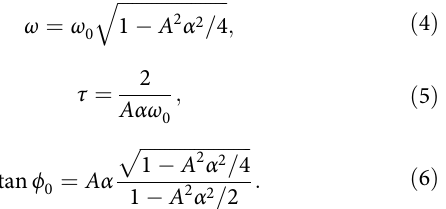
Fig. 2 Z -mode precession in YMnO 3 . a Time-resolved Faraday rotation following the impulsive optical excitation at time t = 0. b Magni fi ed view of the region around t = 0. c Offset-corrected oscillation (see Methods section). The red line is an exponentially damped sine- fi t with the dashed line as its envelope. The extrapolation of the fi t towards t = 0 is shown in b and reveals a fi nite de fl ection at t = 0. This initial de fl ection yields a temporal shift of the spin precession by ~280 fs, which amounts to an initial phase of 0.1 for a precession with a period of 18.2